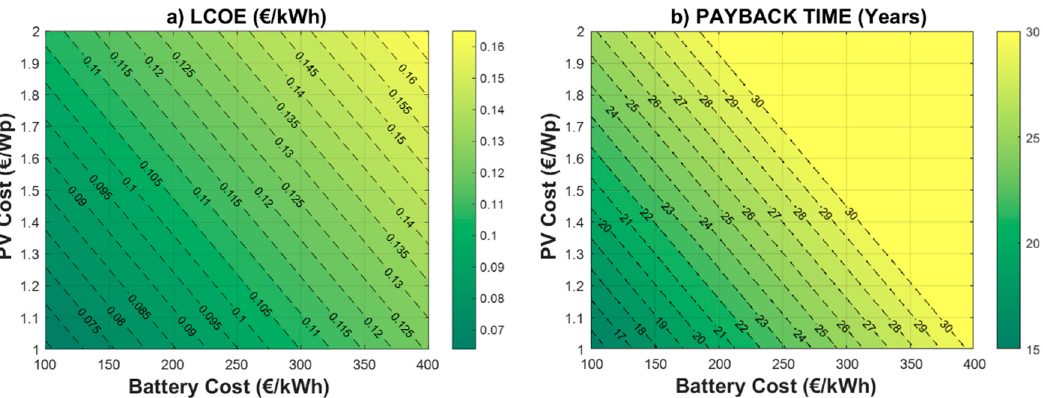
Figure 16. Economic analysis of Case 3: ( a ) levelized cost of electricity as function of PV investment costs and battery investment costs; and ( b ) payback time as function of PV investment costs and battery investment costs.